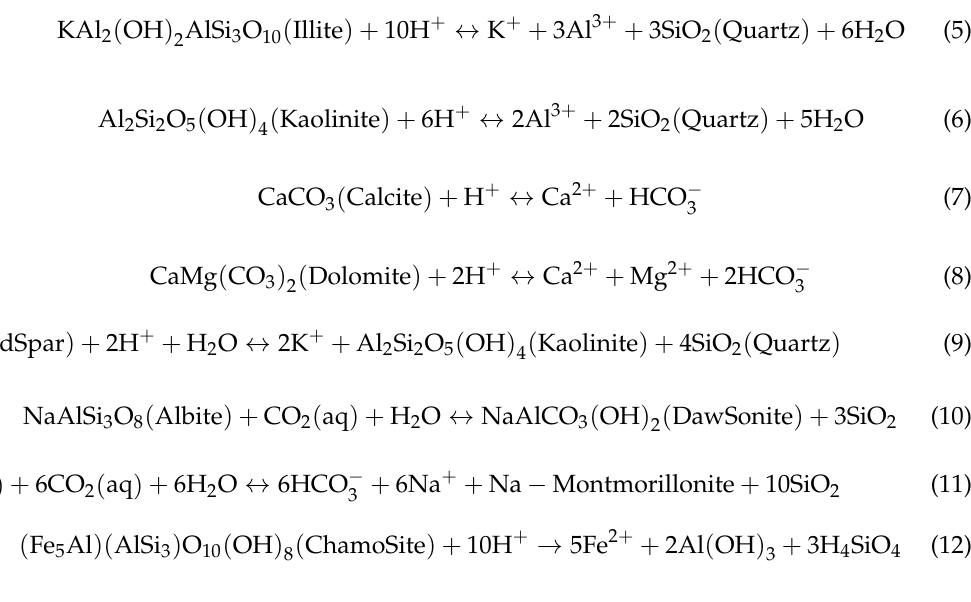
Table 3. Changes of shale after shale reacted with CO 2 at 70 ◦ C and 18 MPa for 30 days [29,55].